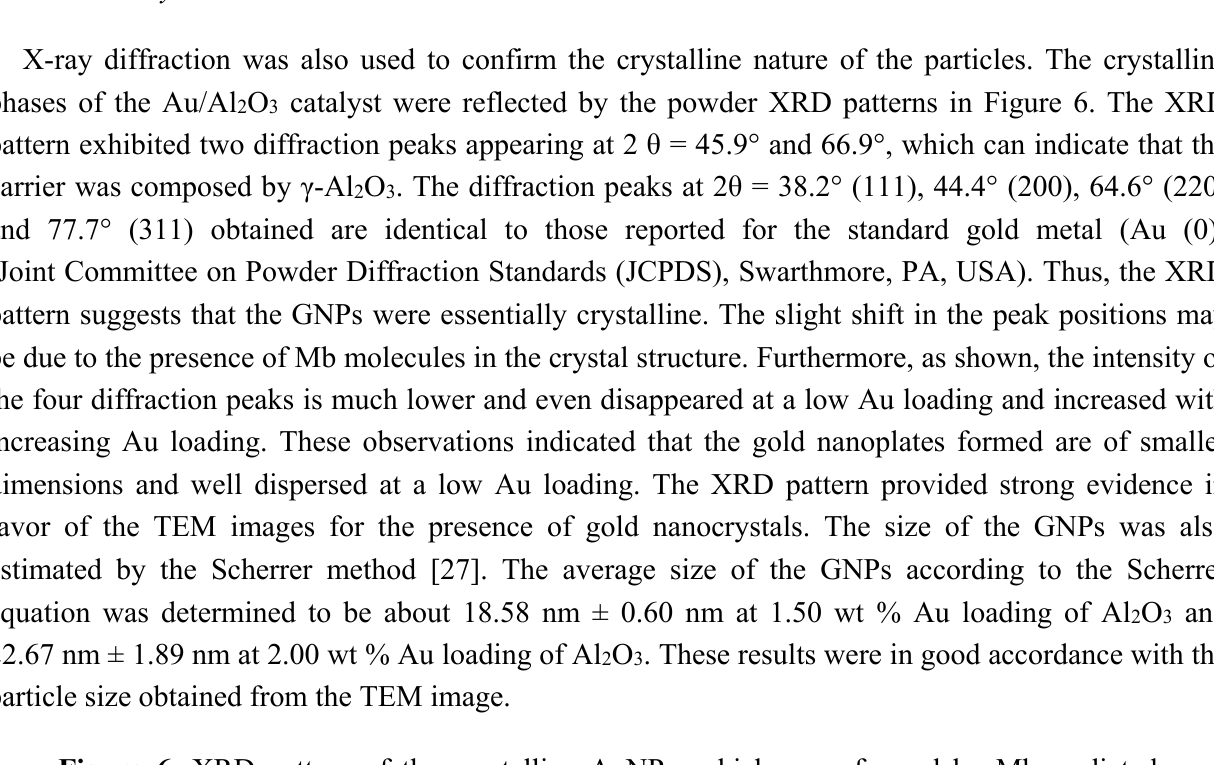
Figure 6. XRD pattern of the crystalline AuNPs, which were formed by Mb-mediated bioreduction (a) Al 2 O 3 ; (b) 0.25 wt % Au/Al 2 O 3 ; (c) 0.50 wt % Au/Al 2 O 3 ; (d) 1.00 wt % Au/Al 2 O 3 ; (e) 1.50 wt % Au/Al 2 O 3 ; (f) 2.00 wt % Au/Al 2 O 3